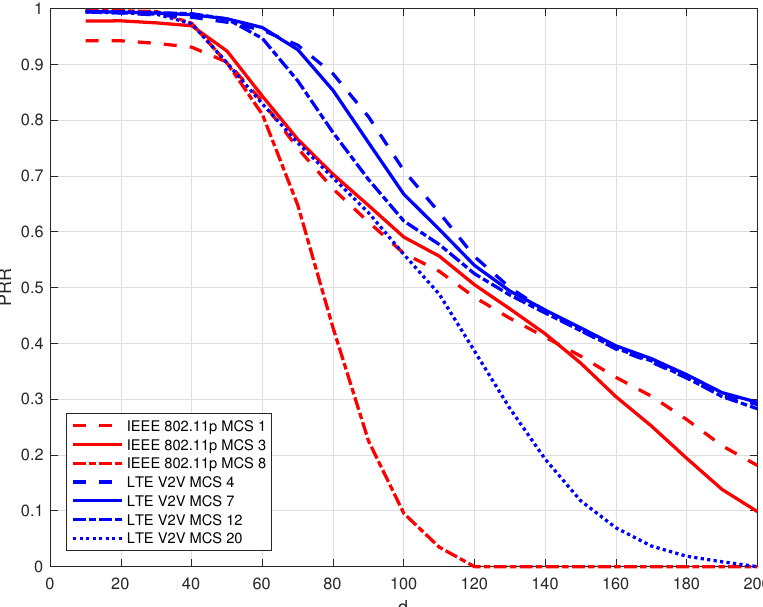
Figure 4. Packet reception ratio (PRR) vs. transmitter–receiver distance: comparison between IEEE 802.11p and LTE-V2V for different